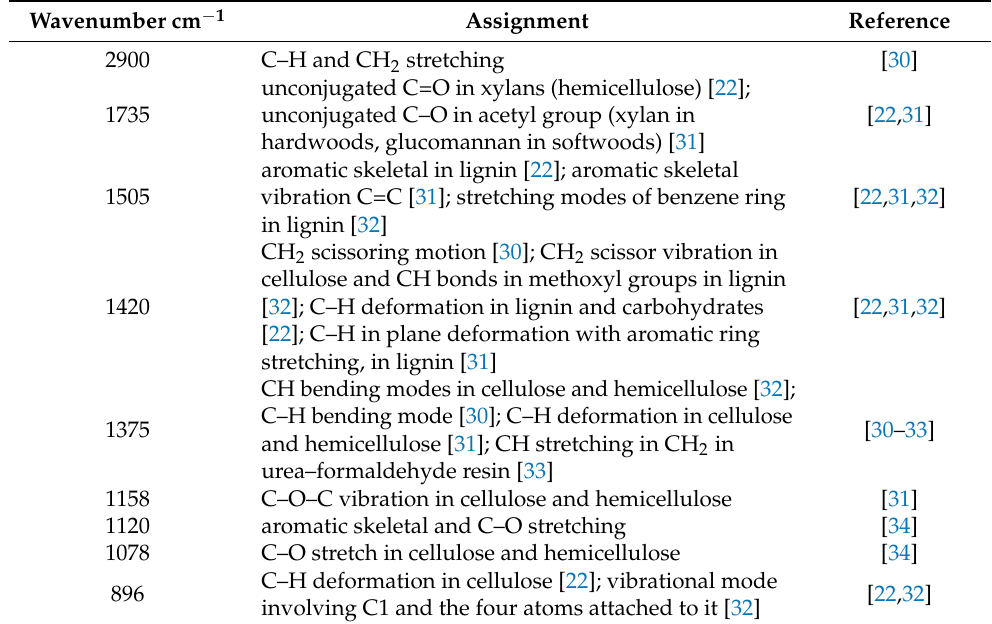
Table 1. Wavenumbers and their